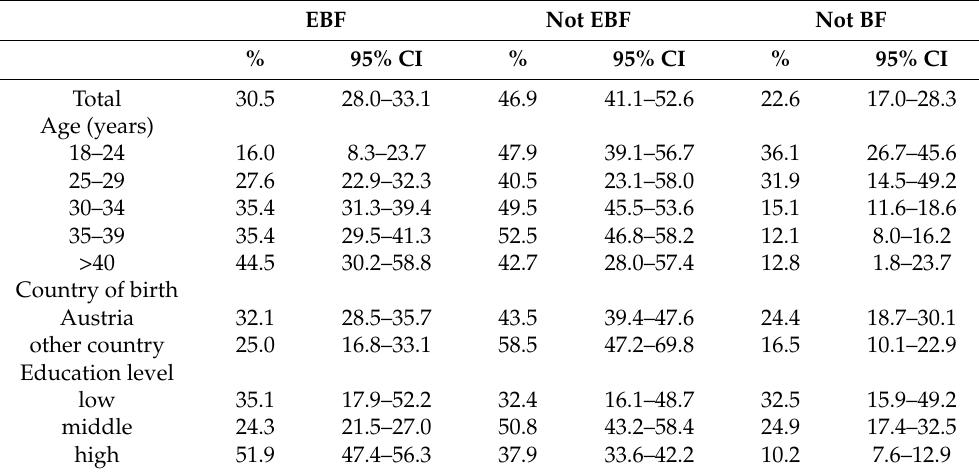
Table 2. Prevalence of exclusively breastfeeding (EBF) mothers, not exclusively breastfeeding mothers and not breastfeeding (BF) mothers at completed 4 months after delivery separated by age, country of birth and education level in % of population ( n =